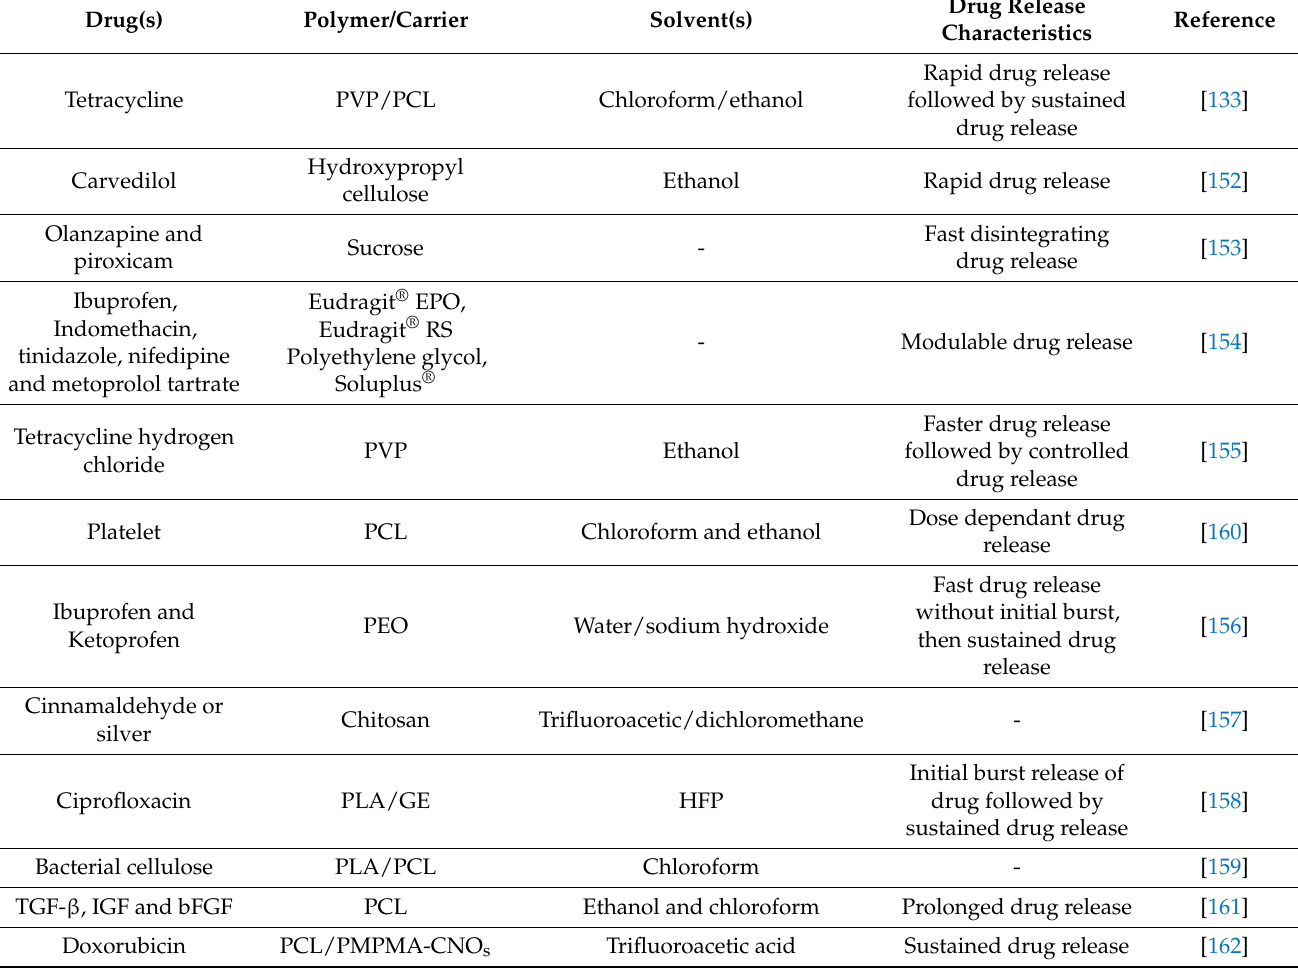
Table 7. Some of the examples of centrifugal spinning in drug delivery